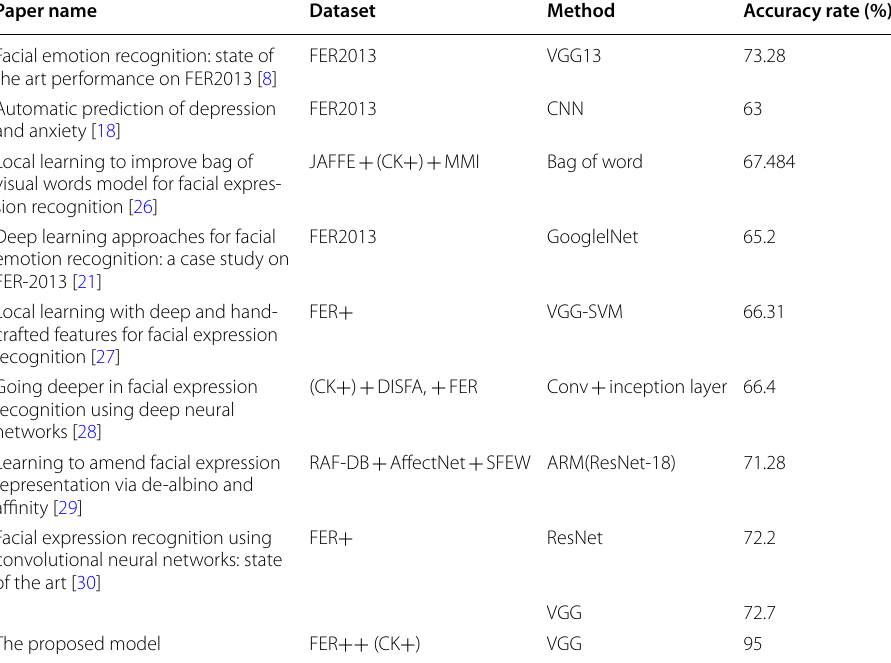
Table 3 Classification accuracies